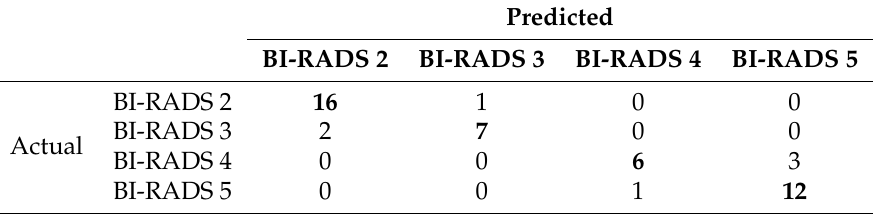
Table 8. CNN confusion